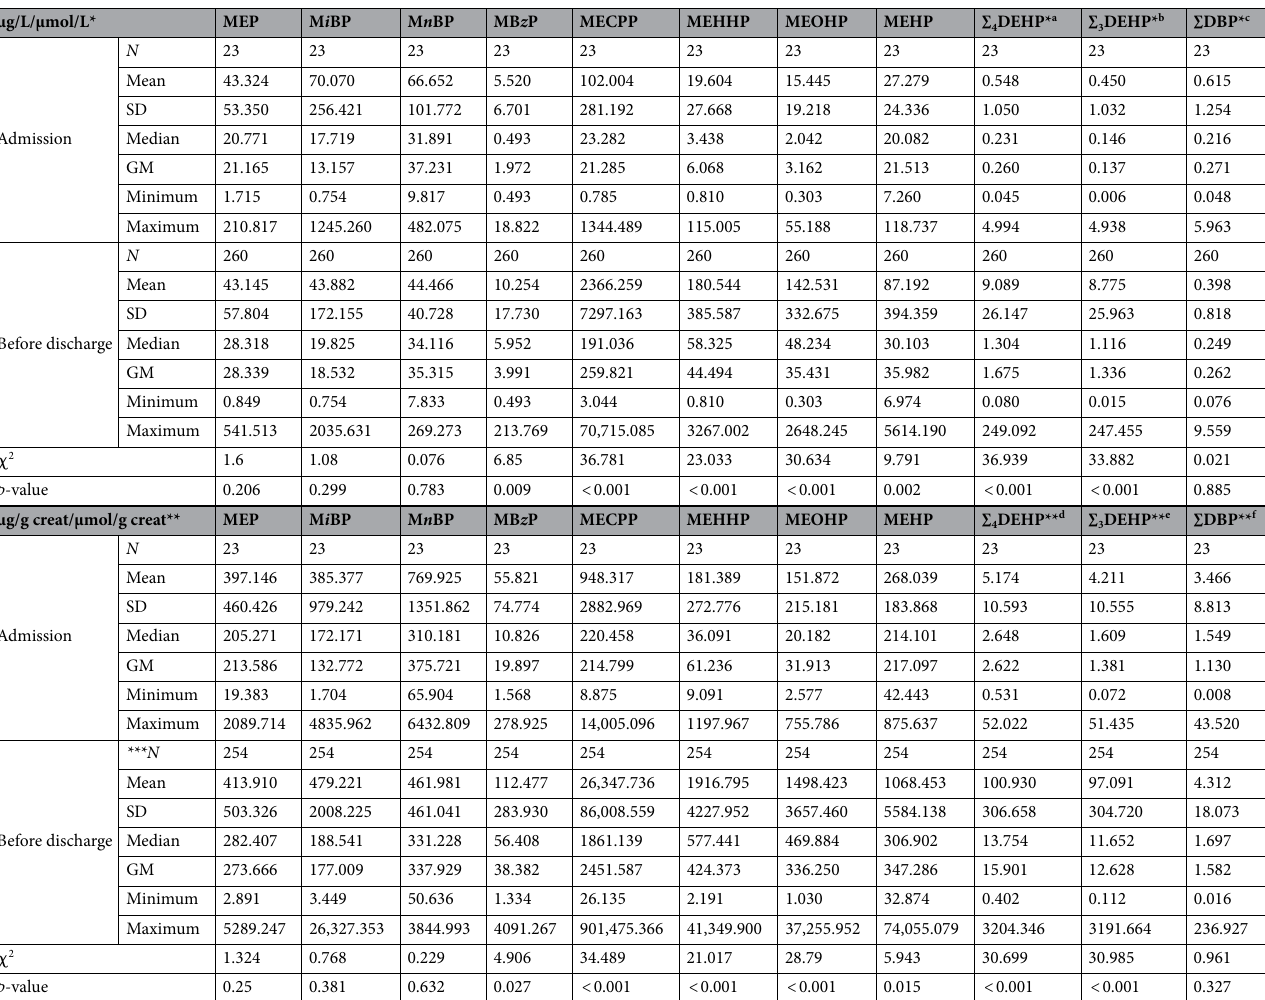
Table 2. Descriptive statistics of urinary phthalate metabolites (µg/L and µg/g creat) in premature neonates (admission and before discharge from the NICU). SD: standard deviation; GM: geometric mean;